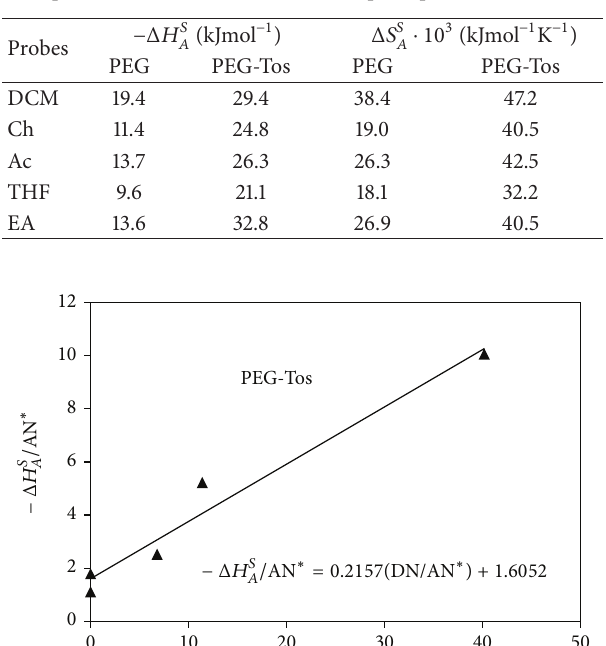
the slope and 𝐾 𝐷 as the intercept (Figures 7 and 8 for PEG and PEG-Tos,